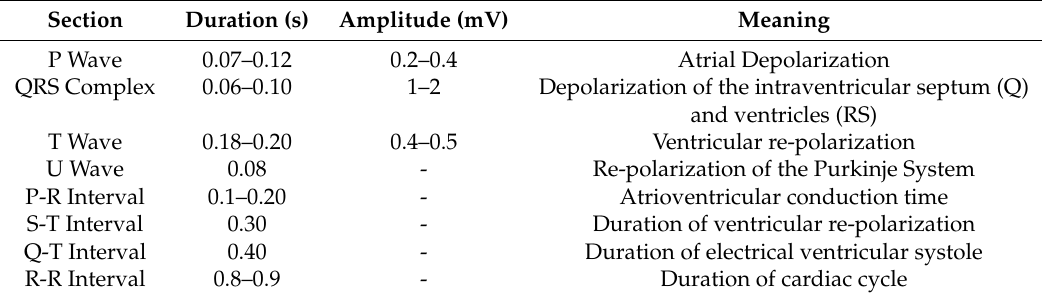
Table 1. Characteristics of an ECG